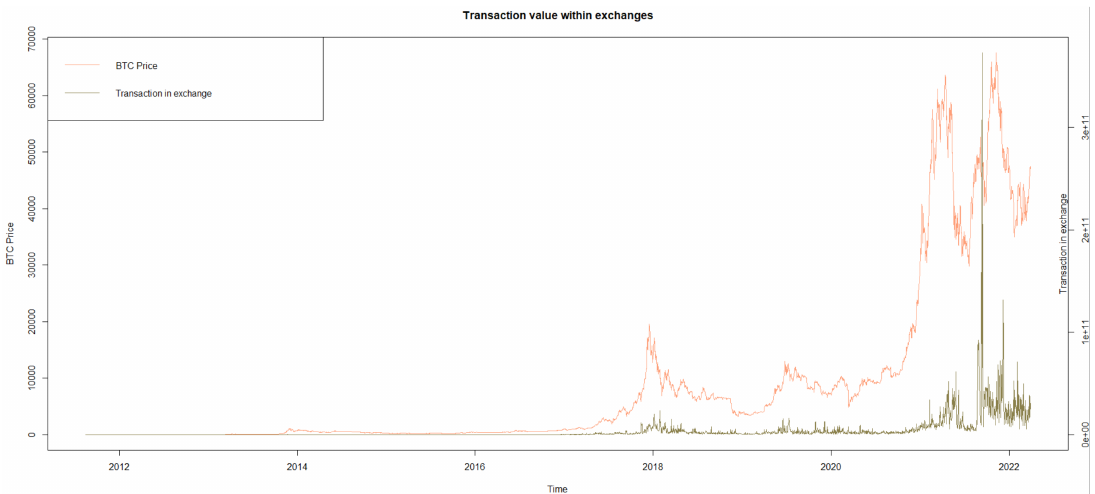
Figure 6. Bitcoin price and daily transactions value within